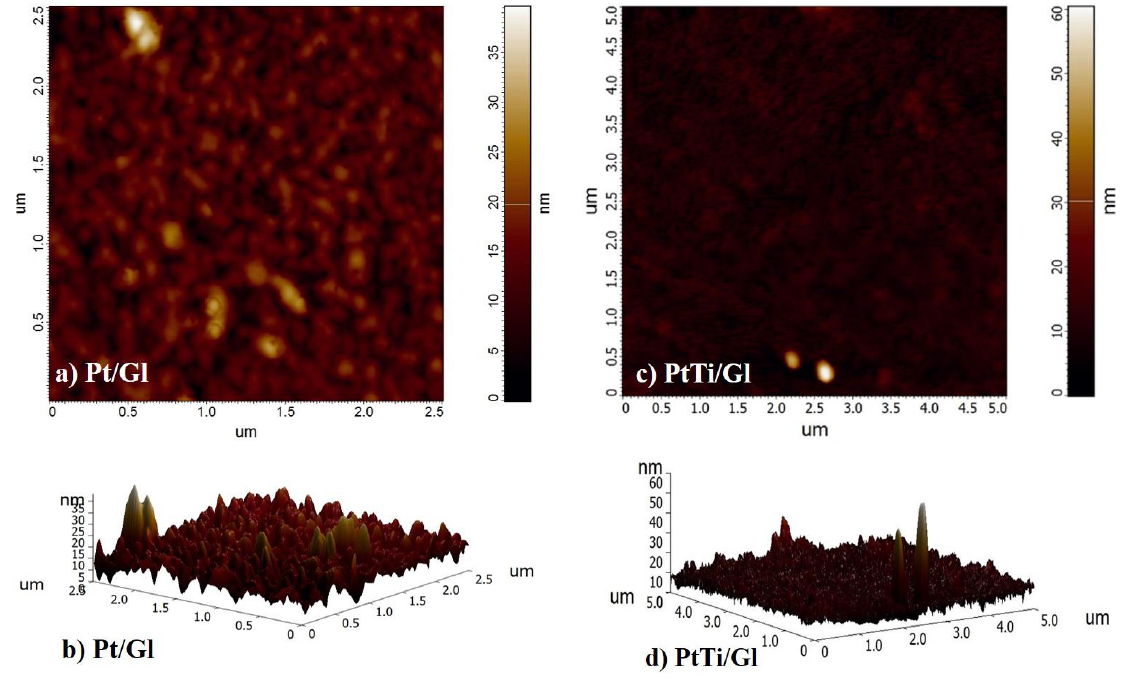
Figure 7. 2D ( a ) and 3D topography map ( b ) for Pt; 2D ( c ) and 3D topography image ( d ) for PtTi thin film. The studied films were deposited on a glass substrate.